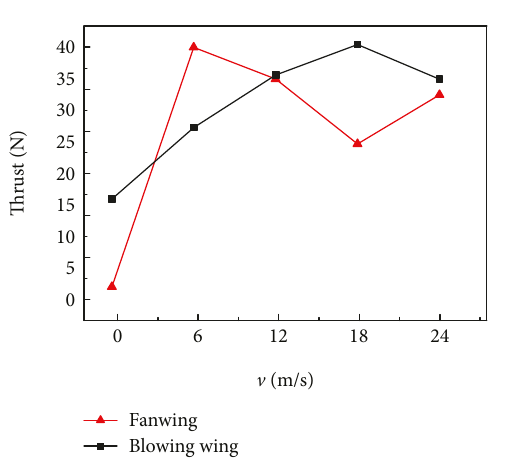
Figure 19: Thrust curve changes with the forward fl ight